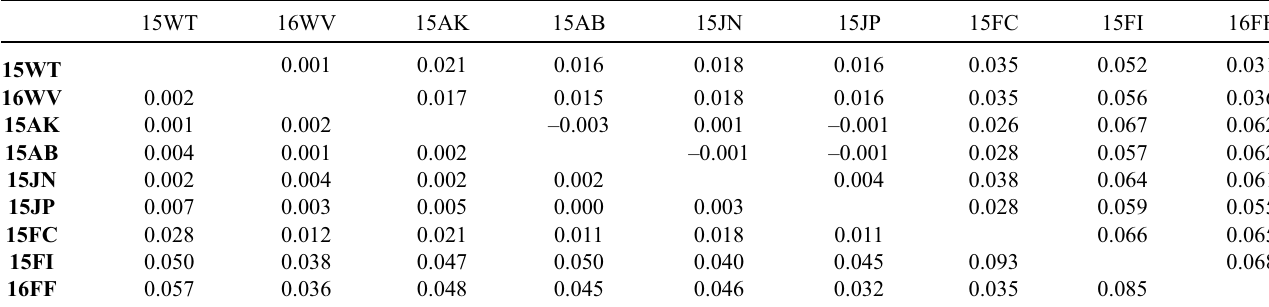
Table 3. Pairwise F ST values based on 3 cgSST loci (below diagonal) and pairwise F ST values based on 19 neutral SST loci (above diagonal) among 9 populations of gilthead seabream from the Adriatic Sea, including wild, farmed, farm-associated and wild juvenile populations. Signi fi cant F ST values are underlined at p < 0.001 (Bonferroni correction). Population codes are explained in Table 1.